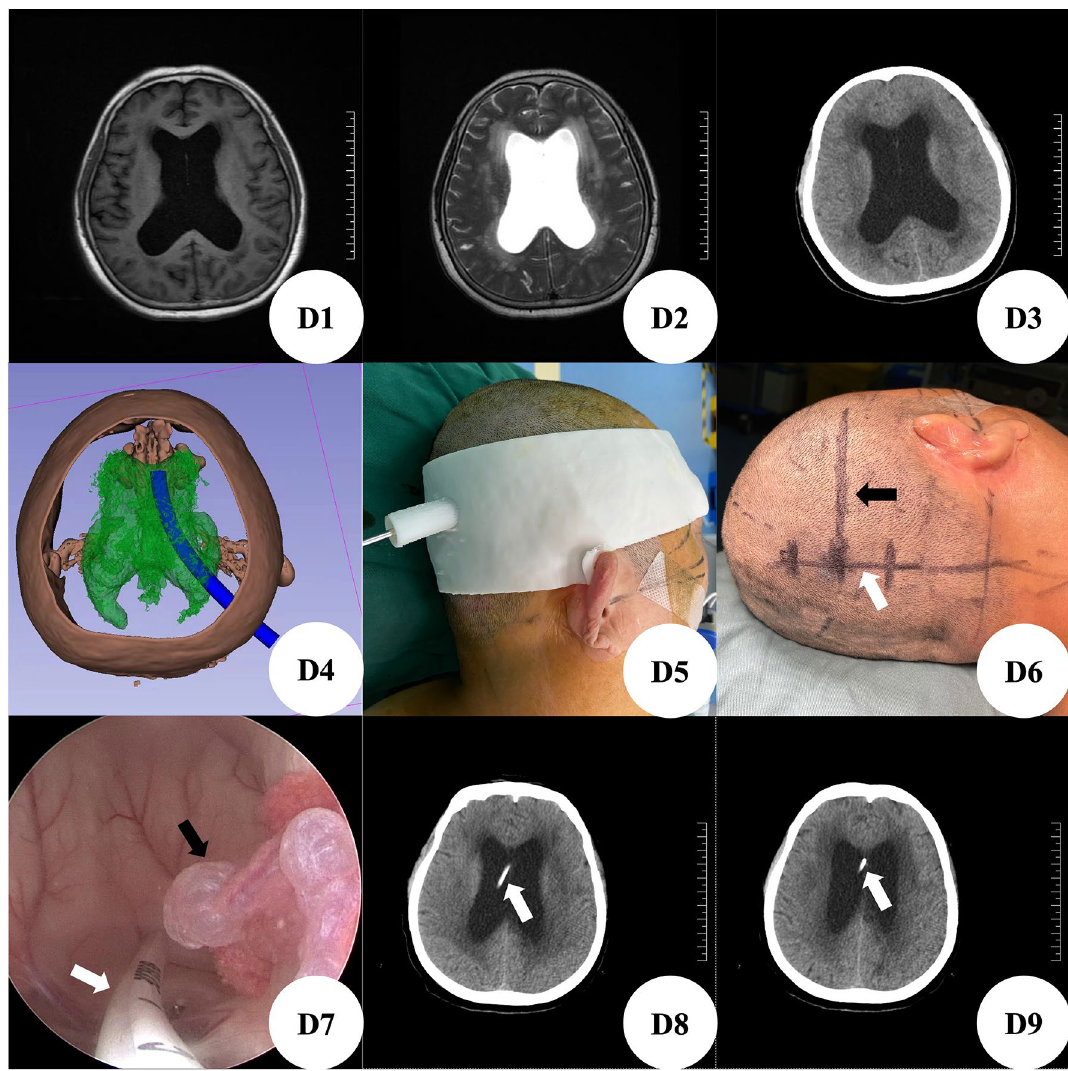
Figure 5. ( D1 – D2 ): Preoperative brain MRI showed hydrocephalus and interstitial edema; D3: Preoperative CT showed hydrocephalus and interstitial edema; ( D4 ): 3D-Slicer reconstructed ventricular system and designed puncture channel; ( D5 ): 3D printing positioning guide; D6: The straight incision (white arrow) is designed according to the positioning guide plate, and the black arrow is the puncture direction; ( D7 ): Choroid plexus and ventricular end of shunt tube from the perspective of transcranial neuroendoscopic; ( D8 – D9 ): Postoperative brain CT showed that the shunt tube was located in the frontal horn of lateral aneurysm clipping surgery 3,4 , trigeminal nerve/facial nerve microvascular decompression surgery 6 , and even craniotomy brain tumor surgery. Study 10 has shown that transcranial neuroendoscopic is more than 90% of hematoma removal in intracerebral hemorrhage surgery. Moreover, the side injury is small, the complications are few, and it is safe and effective. Our previous study 11 showed that after the fibrin interval of chronic subdural hematoma was removed by transcranial neuroendoscopic minimally invasive surgery, all patients recovered well without recurrence. All drainage tubes were placed accurately without complications. This method has clear vision, less trauma and can reduce the recurrence rate and mortality. The advantages of transcranial neuroen- doscopic have been brought into full play in the microvascular decompression of trigeminal nerve/facial nerve. In our previous clinical study 6 , transcranial neuroendoscopic technology can observe the relationship between blood vessels and nerves from multiple angles and explore suspicious compression areas that cannot be observed by microscope. All patients completely used transcranial neuroendoscopic for microvascular decompression and achieved satisfactory results. There were almost no long-term complications except that some patients had vertigo and vomiting in the perioperative period. Of course, transcranial neuroendoscopic also has disadvan- tages. Transcranial neuroendoscopic is a two-dimensional image, which can’t provide three-dimensional depth perception, and there is the so-called “black under the lamp”, that is, it is impossible to observe the operation area after the endoscope, and side injuries such as brain contusion and laceration may be caused during the operation.